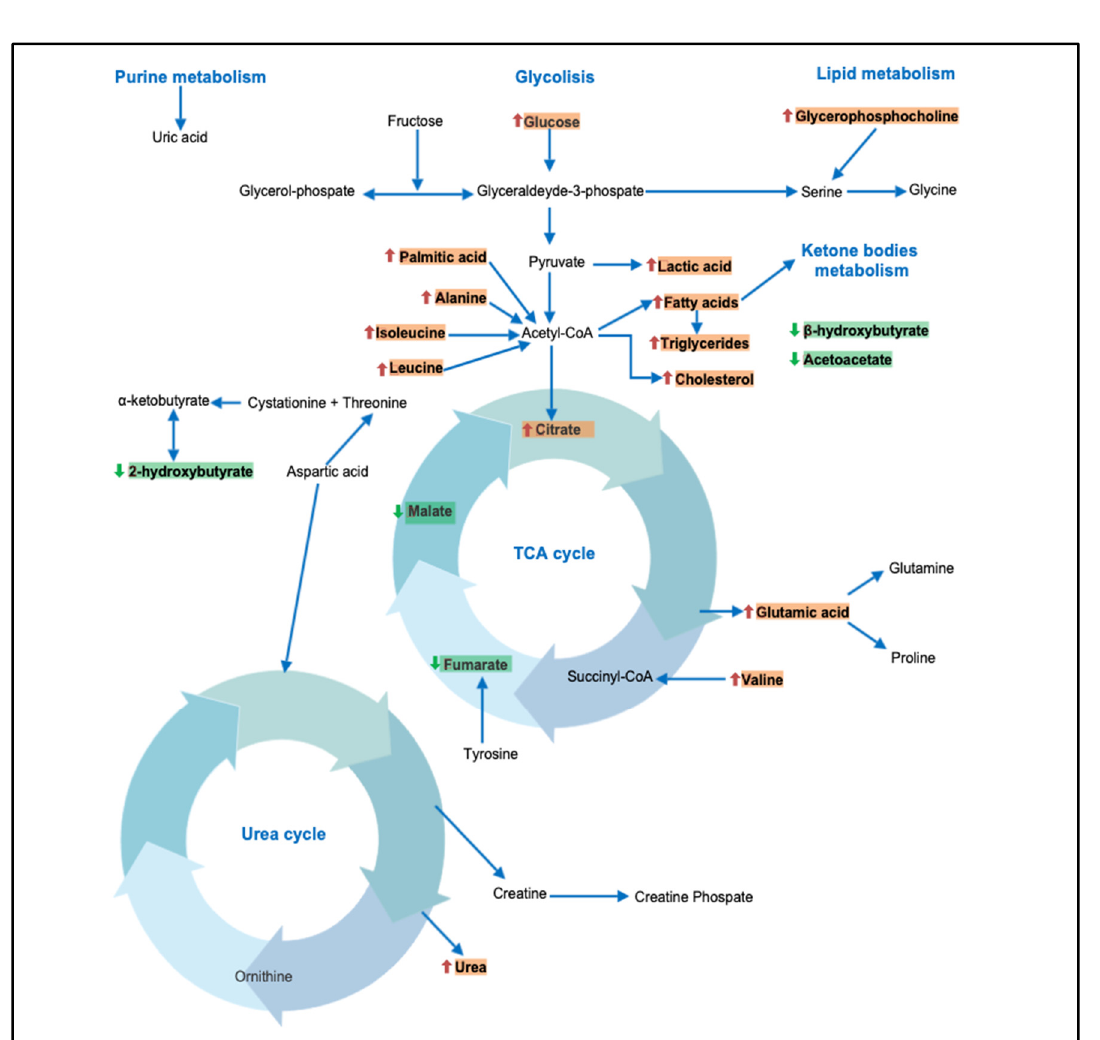
Figure 2. A summary of different pathways potentially involved in NAFLD/NASH. Red arrow: increase in metabolite concentration. Green arrow: decrease in metabolite